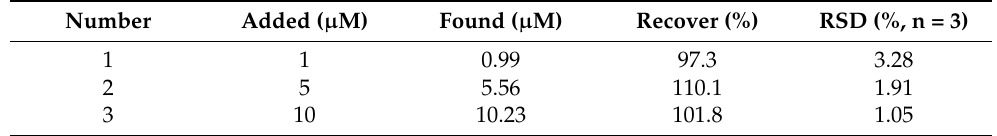
Table 2. The recovery rate of standard addition of Fe 3+ in tap